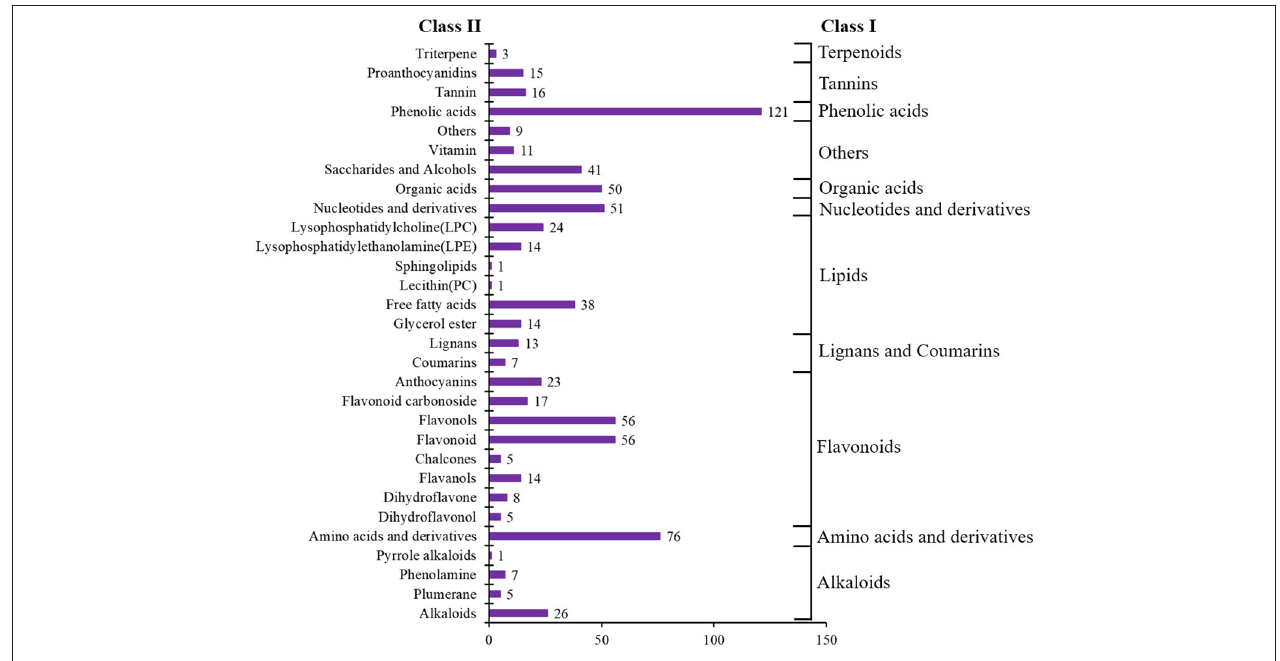
FIGURE 2 | Number of metabolite categories identified in all samples.